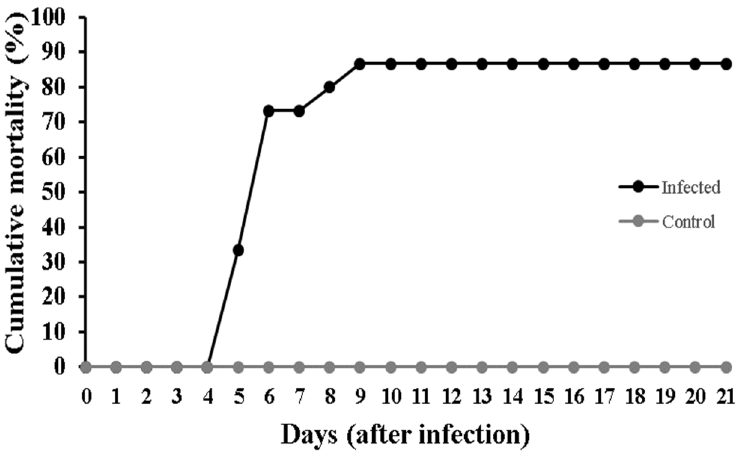
Figure 1. Percentage of cumulative mortality recorded in European seabass ( Dicentrarchus labrax ) control and RGNNV-infected fish, using triplicate tanks of ten fish per group.